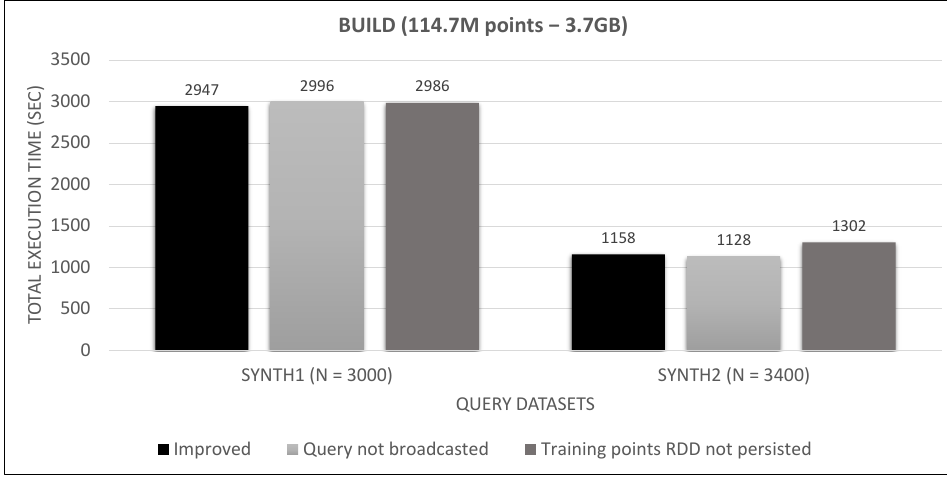
Figure 32. Medium training dataset broadcast and persist tests.